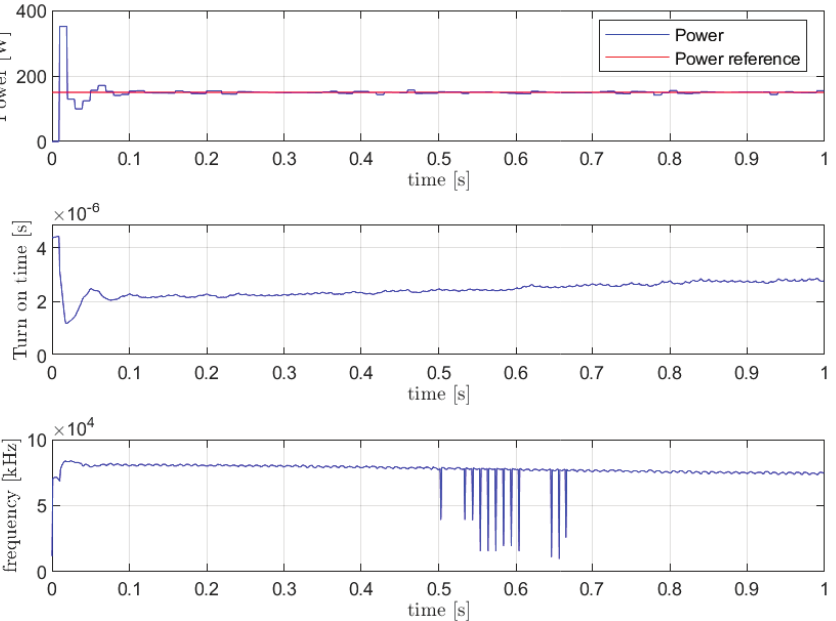
Figure 9. Power transient due to PFM control, turn-on time and estimated frequency in the control horizon during the anisotropy sliding ( v z = 3 cm/s).